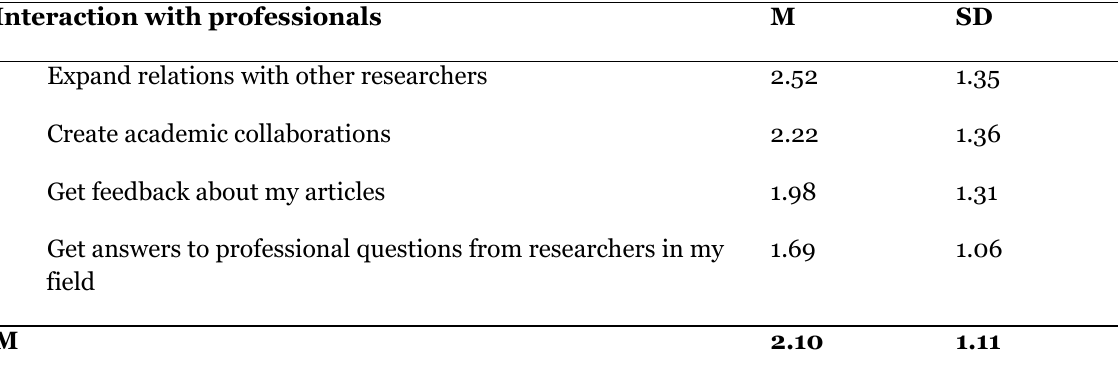
Interaction with